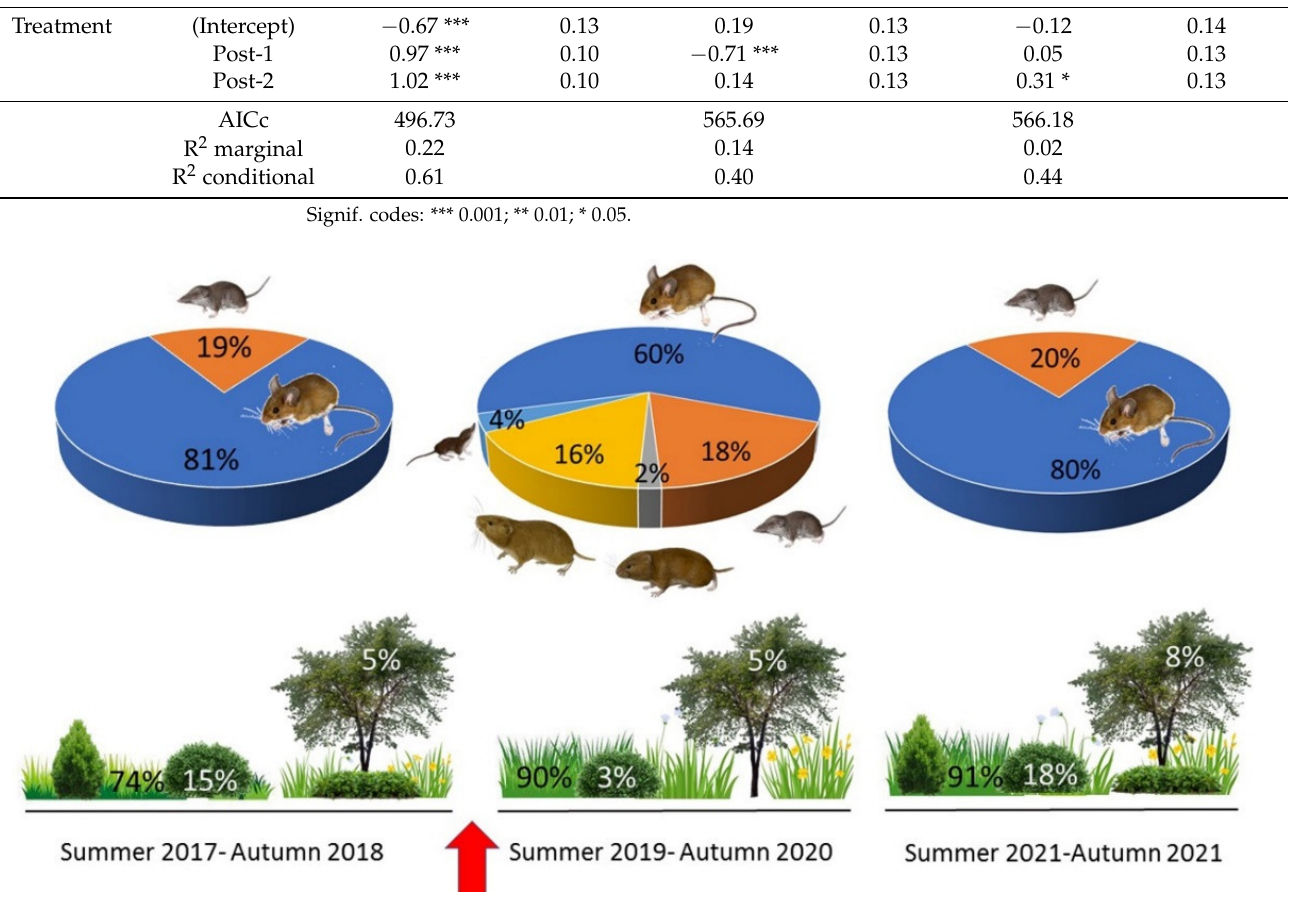
Figure 3. Graphical representation of changes that occurred in the sampling plot along the study period (summer 2017–autumn 2021), regarding the intervention to control for shrub encroachment (red arrow), and their effects on vegetation cover profiles (herbs, short and tall shrubs) and the small mammal community (frequencies of occurrence).